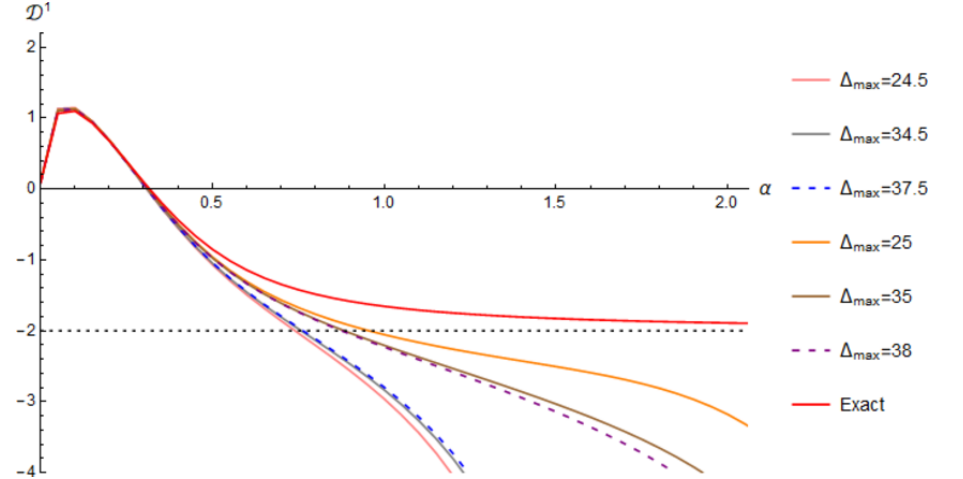
Figure 6. D 1 ( e 1 (cid:0) e 0 ) versus (cid:11) > 0 for the free spectator. Linear term removed using regression s analysis on the interval 2 < (cid:11) <